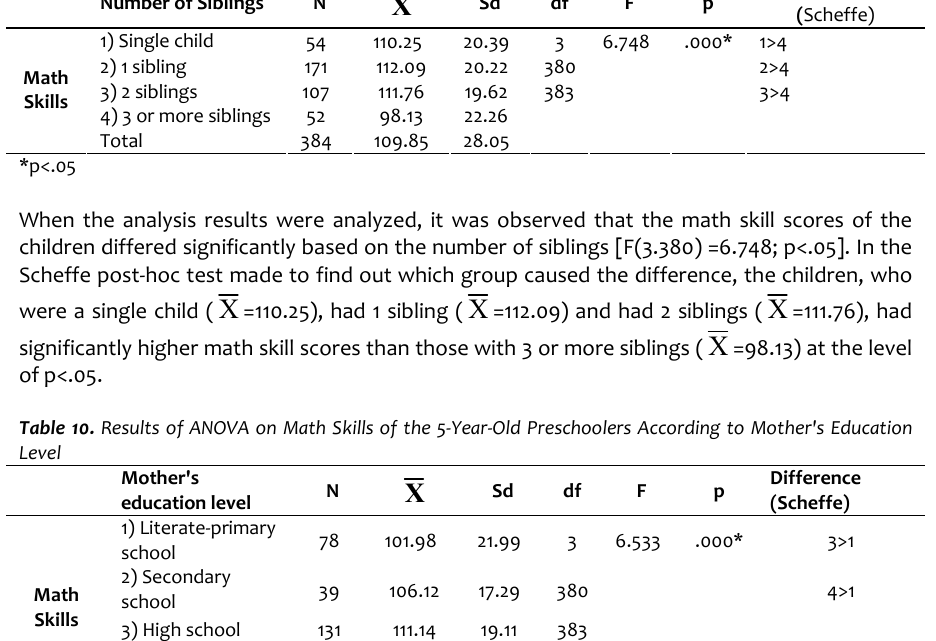
Table 9. Results of ANOVA Test Analysis on Math Skills of the 5-Year-Old Preschoolers based on Number of Siblings Number of Siblings